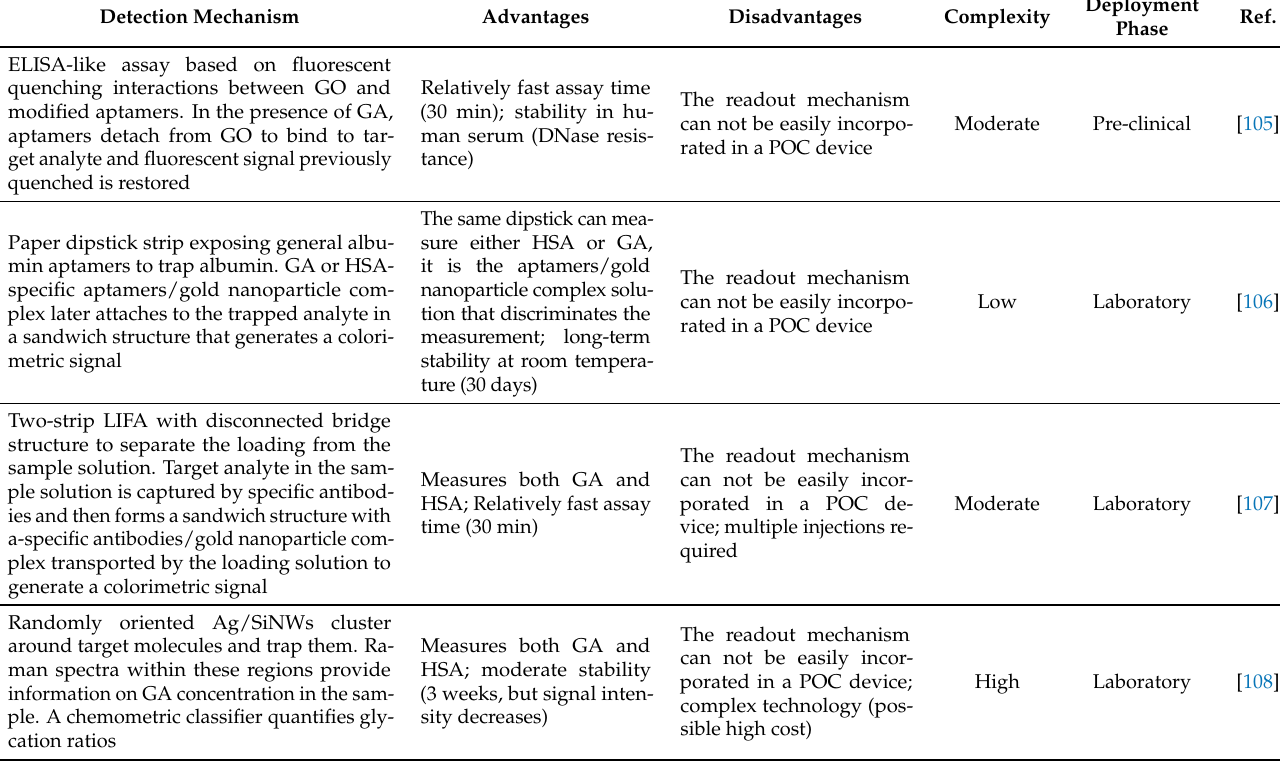
Table 6. Additional relevant approaches